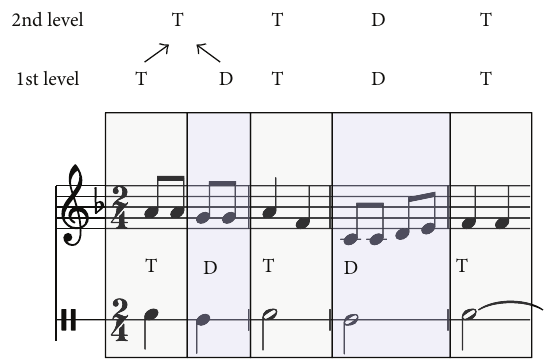
Figure 2: A popular melody’s harmonic rhythm and levels of group- ing